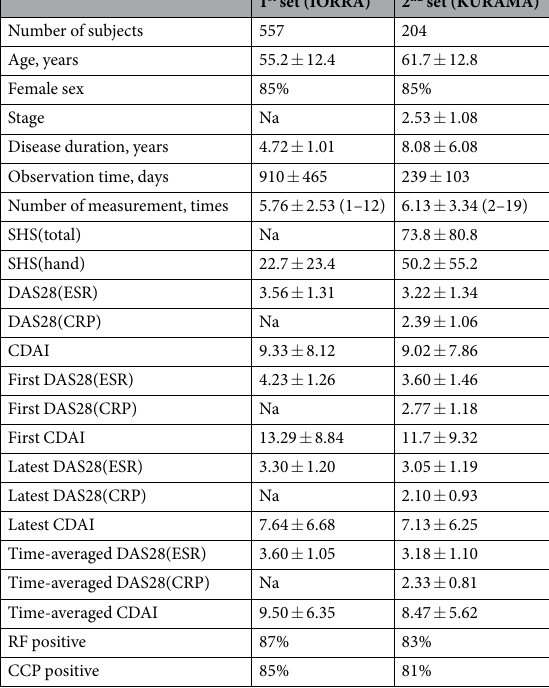
Table 1. Since the IORRA cohort had joint X-rays around five years after disease onset with periodical disease activity data, this cohort is similar to the model in Fig. 1B. Since the KURAMA cohort had joint X-rays with vari- able disease duration and data of many time points of disease activity, this serves to address the model in Fig. 1C. We calculated time-averaged DAS28 in each patient based on the methods illustrated in materials and meth- ods and Fig. 1A. Mean and standard deviation of the time-averaged DAS28 seemed comparable to those in one-time DAS28 (Table 1), indicating difference observed between one-time and time-averaged DAS28 could not be explained by difference in score of DAS28 itself. We first performed linear regression analysis with time-averaged DAS28 as an independent variable using RF and disease duration as covariates in the 1 st set. We obtained R squared value (R 2 ) of the model and compared it with those of the 1000 models using one-time DAS28 (for details, see Materials and Methods). As a result, we found superiority of the time-averaged DAS28 over the one-time DAS28 (p = 0.001, Fig. 2A and Supplementary Table 1). Next, we analyzed data in the 2 nd set in which dense data of disease activity were available for a short period of time in spite of long disease duration. As a result, the 204 samples revealed better fit in the model with time-averaged DAS28 than those with one-time DAS28. (p = 0.034, Supplementary Figure 1 and Supplementary Table 2) When we extracted hand SHS data and conducted the same analysis, we obtained comparable results of superiority of time-averaged DAS28 to one-time DAS28 (p = 0.054, Fig. 2B, and Supplementary Table 1). Next, we used CDAI as an independent variable instead of DAS28 to confirm that our model was robust. Time-averaged CDAI tended to fit better than one-time CDAI in both sets 1 and 2 (Supplementary Tables 1 and 2). We further confirmed that the model by using time-averaged DAS28 consistently tended to fit better than one-time DAS28 where we used log-transformed SHS as alternative dependent variables or used DAS28 (CRP) or log-transformed disease duration as alternative independent variables (Supplementary Tables 1 and 2). When we used one-time DAS28 evaluated at the first visit or at the time nearest the time of joint X-rays instead of randomly selected one-time DAS28, the DAS28 did not show very good fit consistently across the 1 st and 2 nd sets (Fig. 2A and B and Supplementary Tables 1 and 2). Since the IORRA cohort evaluated disease activity every six months, the disease activities for some patients were evaluated at a date far from the date of joint X-rays. However, when we selected the 516 patients whose DAS 28 data were evaluated within six months before joint X-rays, the last DAS 28 again showed a poor fit (Supplementary Figure 2), indicating that disease activity at last visit before or the same time of X-ray does not fit joint destruction very well. When we divided the cohorts according to the number of assessment of DAS28, linear model using time-averaged DAS28 tended to fit well in a subgroup with more time points of DAS28 (Fig. 3). While differ- ence in the characteristics of the two cohorts seemed to result in slightly different tendencies among the quad- rants, a substantially better fit was observed in both cohorts in the quadrant with more than six evaluations (Supplementary Figure 3). Lastly, we analyzed data of the BeSt study to confirm that the current findings are observed in a European cohort with definitive treatment and stringent control of disease activity. The characteristics of the subjects are